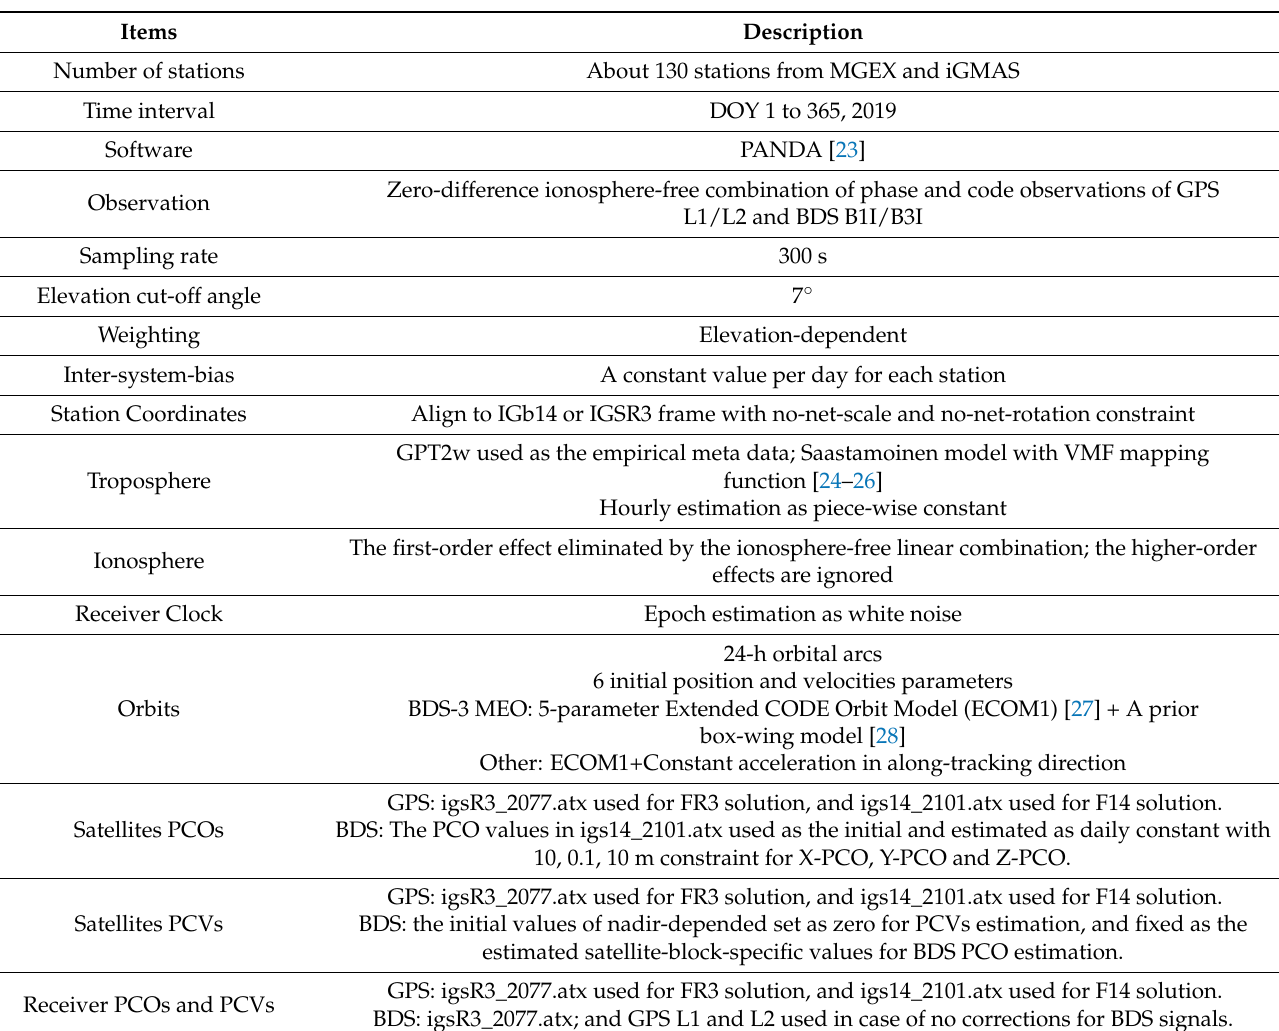
Table 3. Strategy used for PCO and PCV estimation of BDS IGSO and MEO